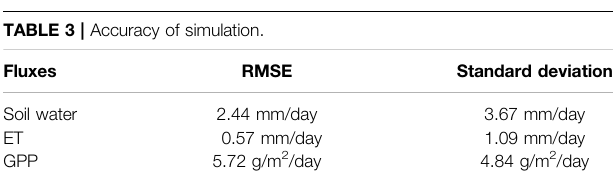
TABLE 3 | Accuracy of